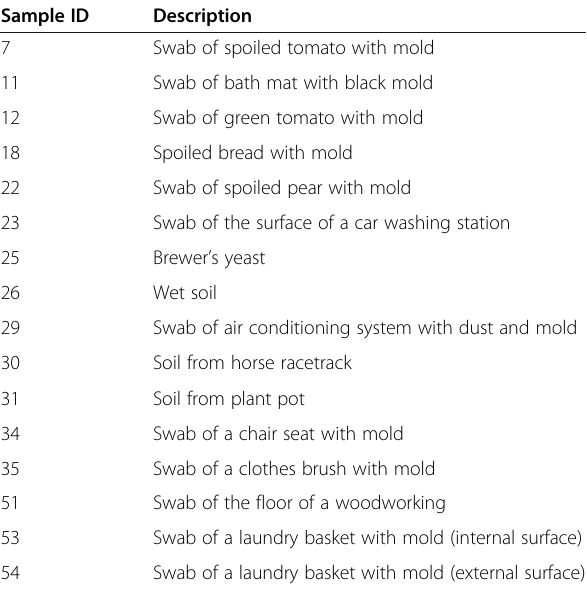
Table 1 A total of 16 samples were selected for the study. The table shows the sample ID and the sample description. The samples have been chosen from indoor and outdoor environments as an example of items contaminated by fungi that can characterize specific milieus. Sample 25 was included as a positive control, due to the fact that brewer ’ s yeast is mainly composed of